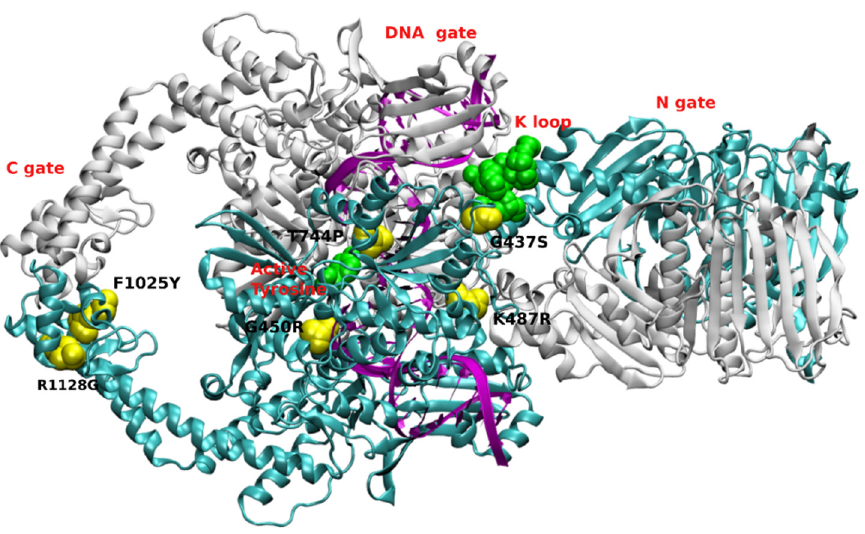
Figure 3. Pictorial representation of selected single mutations (yellow spheres) in yeast topo II enzyme (PDBID: 4GFH) spotted in both ATP binding domain and DNA cleavage/re-ligation domain. Green spheres represent catalytic tyrosine and K-loop. Each of the dimers is represented in either gray color or cyan color for distinction with DNA as violet ribbon.